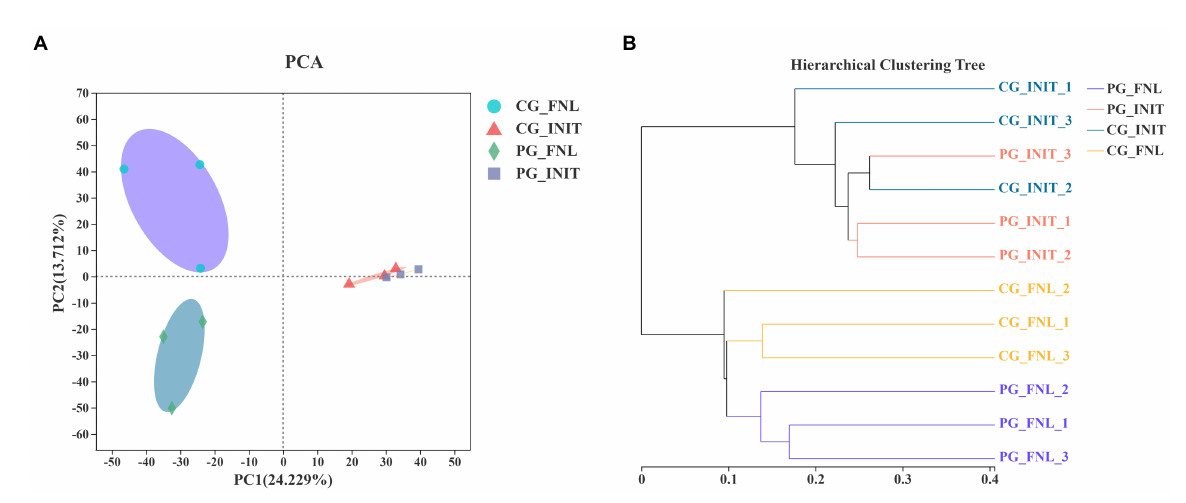
FIGURE 6 Principal component analysis (PCA; A ) and unweighted pair-group method with arithmetic means (UPGMA) hierarchical cluster analysis (B) of the bacterial communities based on Bray-Curtis distance over all samples. PG_INIT and CG_INIT represent the PG and CG groups at the initial stage of the experimental period, respectively. PG_FNL and CG_FNL represent the PG and CG groups at the final stage of the experimental period, respectively.